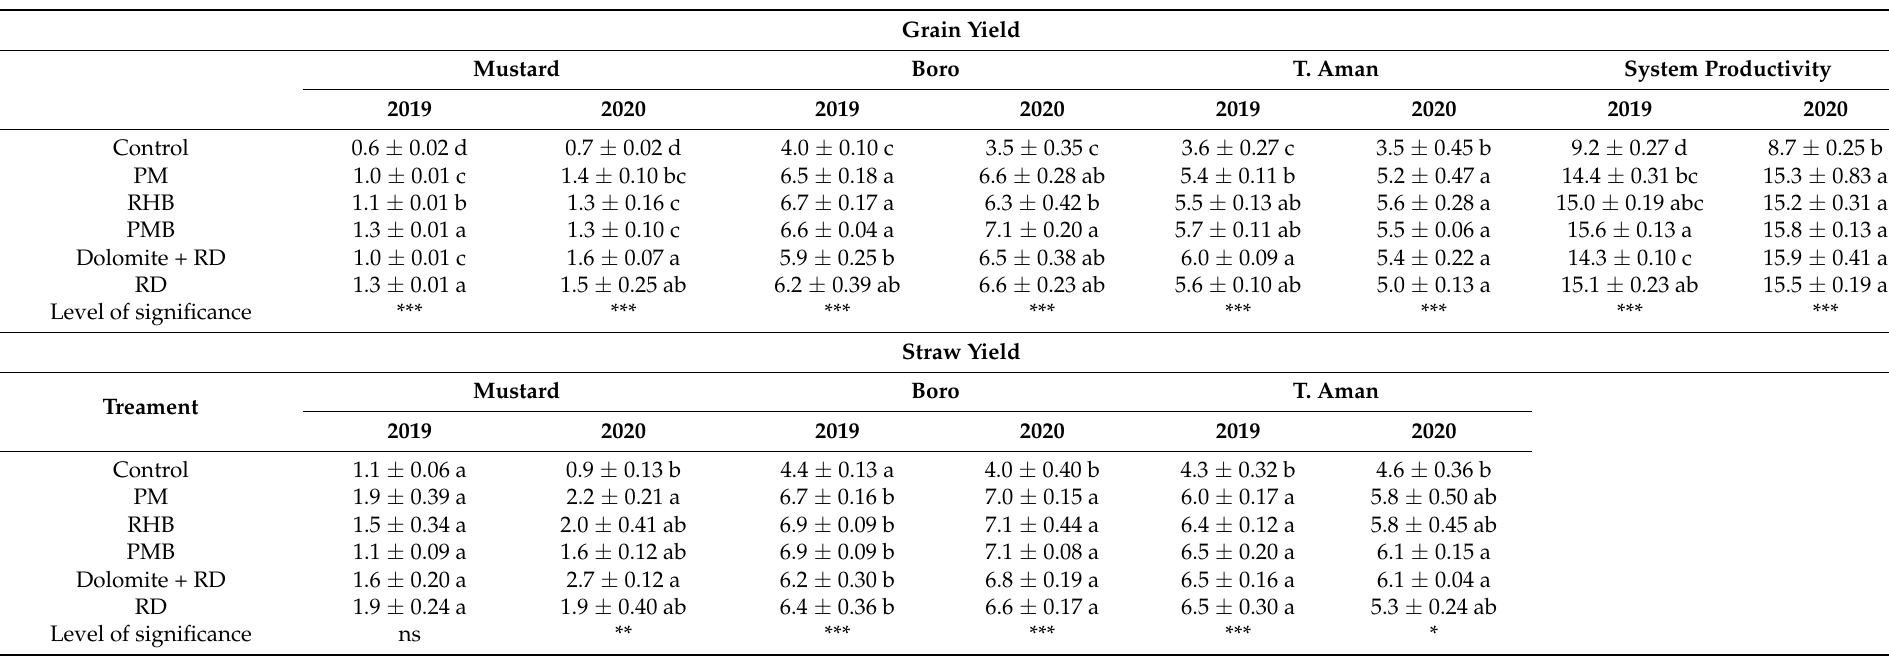
Table 5. Effects of different treatments on crop yield and system productivity of Mustard-Boro-T. Aman rice cropping pattern in acidic soil. Grain Yield Mustard Boro T.